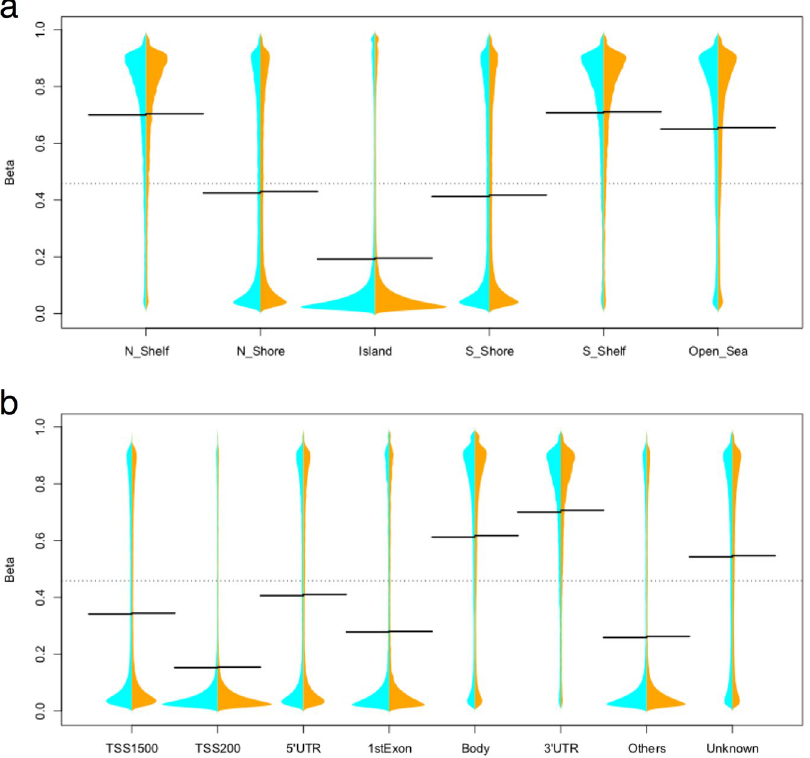
Figure 1. Methylation levels in pre-receptive (cyan, left) and receptive (orange, right) endometrium represented as split beanplots. The width of the plot represents the distribution of data, the black line shows the mean methylation value in group, while the dashed black line represents the overall average methylation level. ( a ) According to location (relative to CpG islands). The x-axis denotes the CpG island location while the y-axis denotes methylation β -values (0 to 1). ( b ) According to the region functional categories. The x-axis denotes the functional group while the y-axis denotes methylation β -values (0 to 1). CpGs annotated to multiple gene locations are labelled as ‘Others’, and CpGs with unknown annotations are labelled as ‘Unknown’.